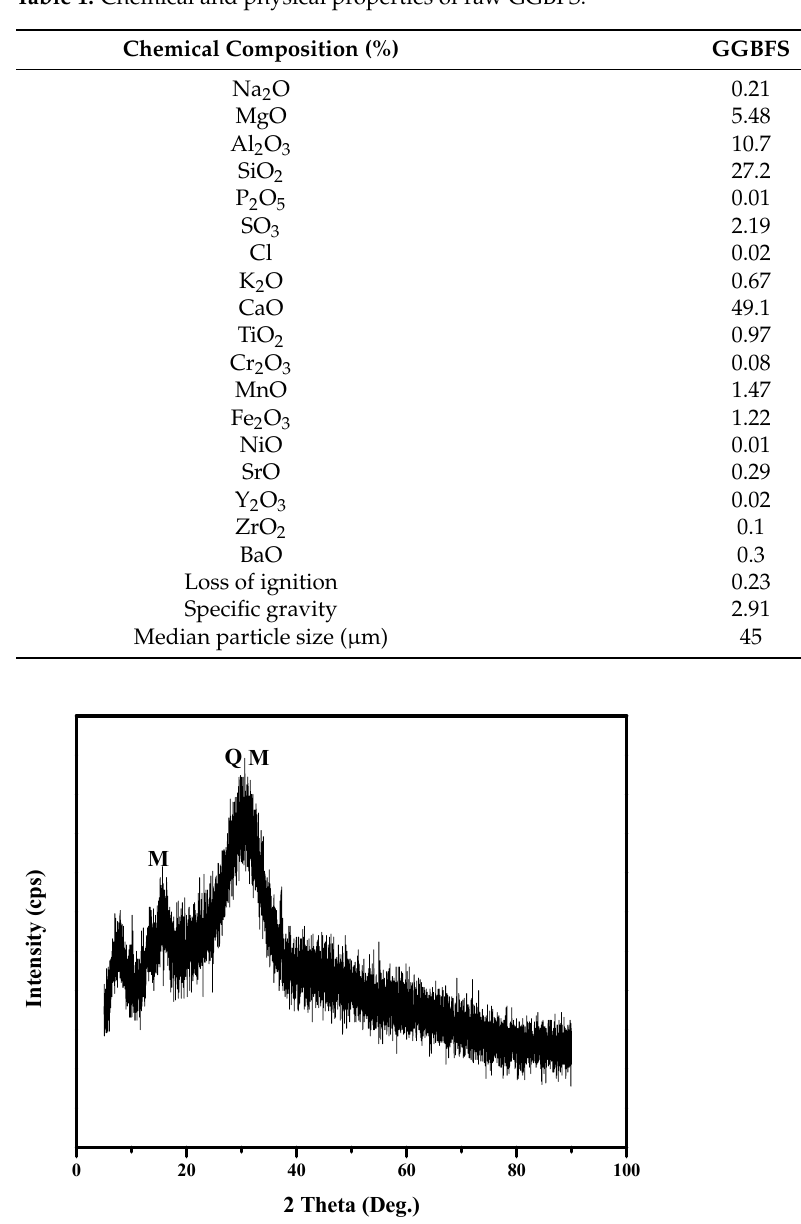
Table 1. Chemical and physical properties of raw GGBFS.